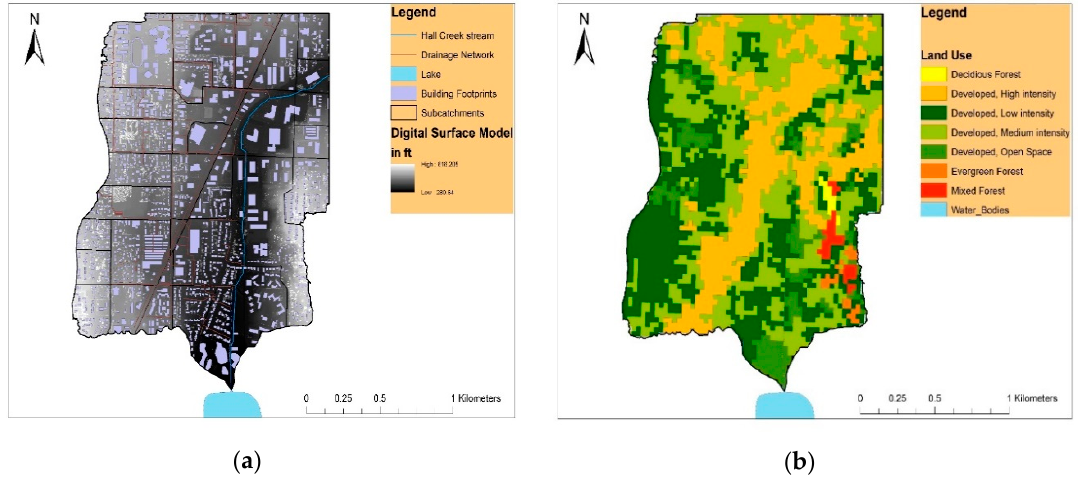
Figure 4. Hall Creek watershed showing ( a ) buildings, drainage network, and the surface elevation as a background, and ( b ) land cover map.